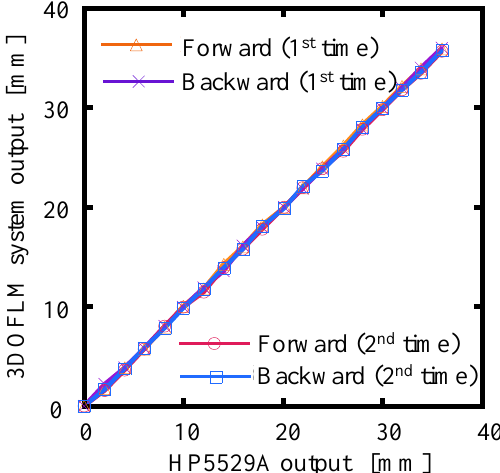
Figure 9. Confirmation of measurement range of the 3DOFLM system.